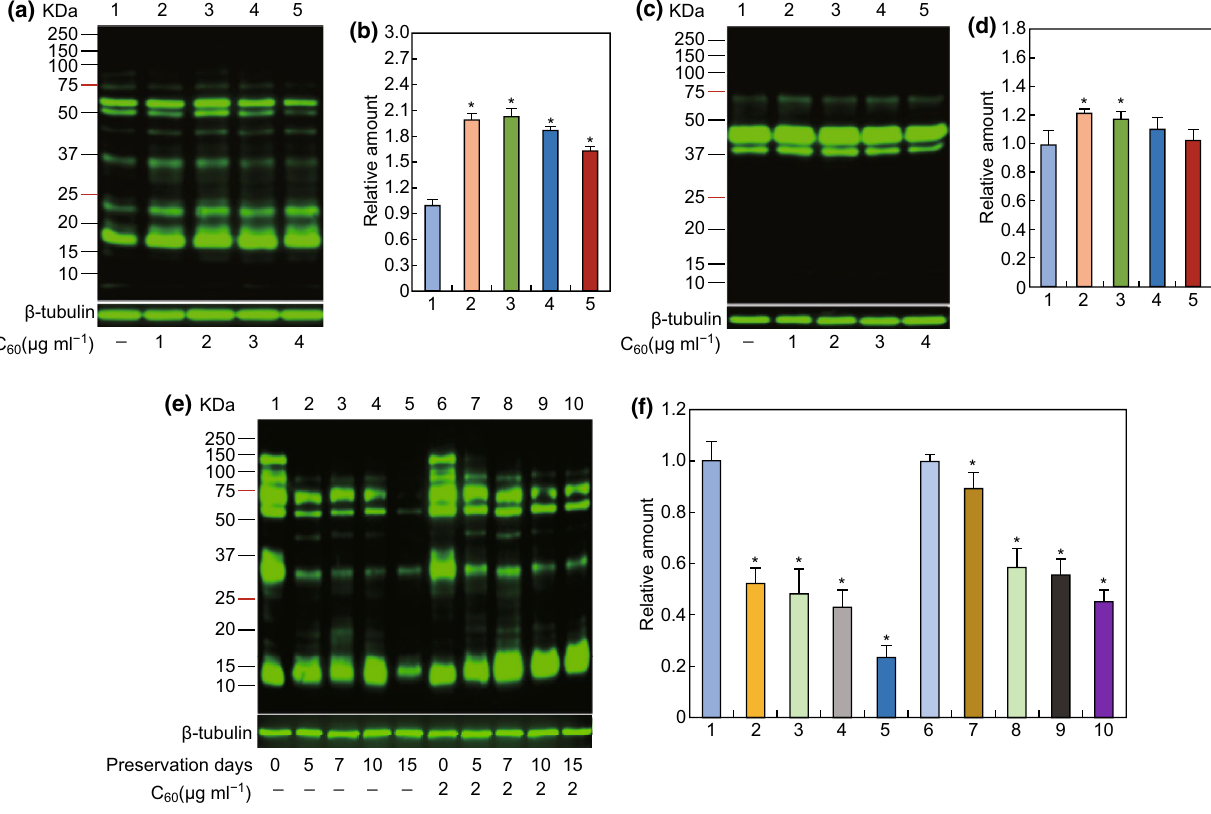
Fig. 4 Western blot analysis of P-PKAs and PTP under different concentrations of carboxylated C 60 . Western blot analysis was performed using a , b an anti-phospho-PKA substrate antibody, c , d an anti-phosphotyrosine antibody, e , f an anti-phospho-PKA substrate antibody. The bands used for histogram quantification are labeled #. β-Tubulin was used as an internal control. The experiment was performed at least three times; the presented image is representative and repeatable. (n = 3, * P <